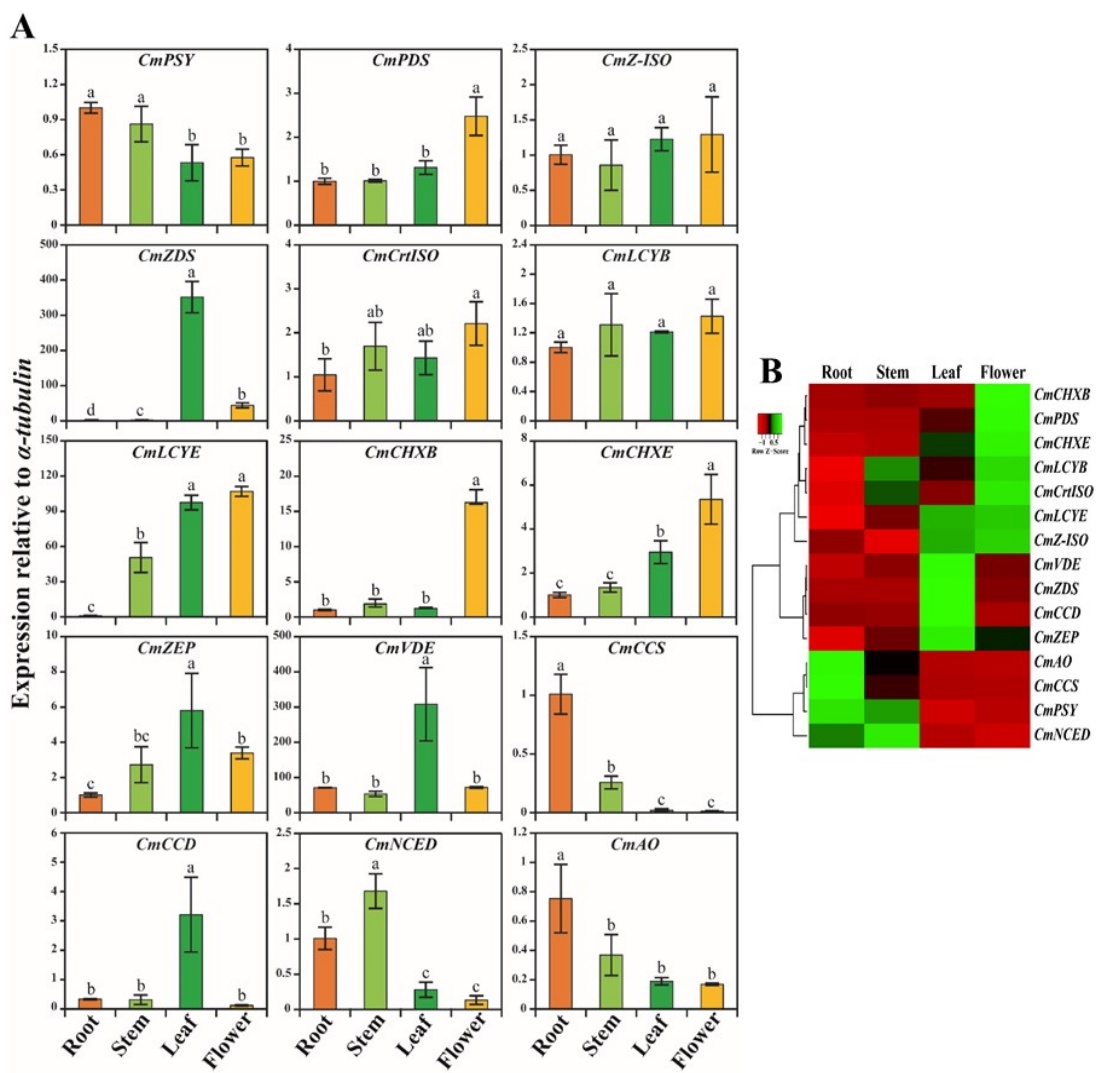
Figure 5. Relative gene expression profiles of eleven CBP, XBP, and ABP genes of Chelidonium majus . ( A ) Expression levels of CBP, XBP, and ABP genes were examined in different organs such as leaf, stem, root, and flower of Chelidonium majus using qRT-PCR. Letters a–e denotes significant differences ( p < 0.05). ( B ) Heat map showing the expression profiles of CBP, XBP, and ABP genes in five different organs of Chelidonium majus . The heat map was constructed using fold-change values gained from qRT-PCR. The tree view of hierarchical clustering was used to display the organ-specific expression of CBP, XBP, and ABP genes. A gradient color bar at the top is used to show whether the CBP, XBP, and ABP genes are up-regulated (red) or down-regulated (green).